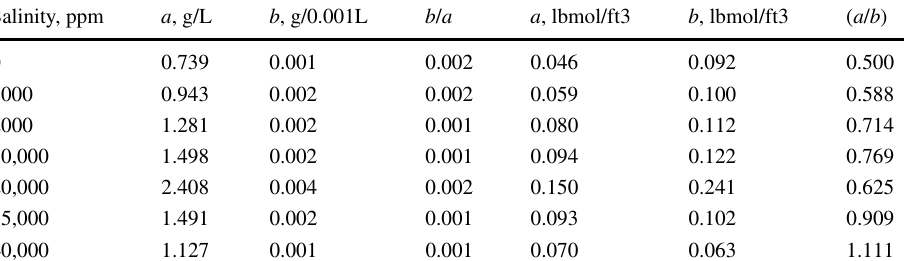
Fig. 6 Apparent viscosity plot for refined xanthan gum at 120°F